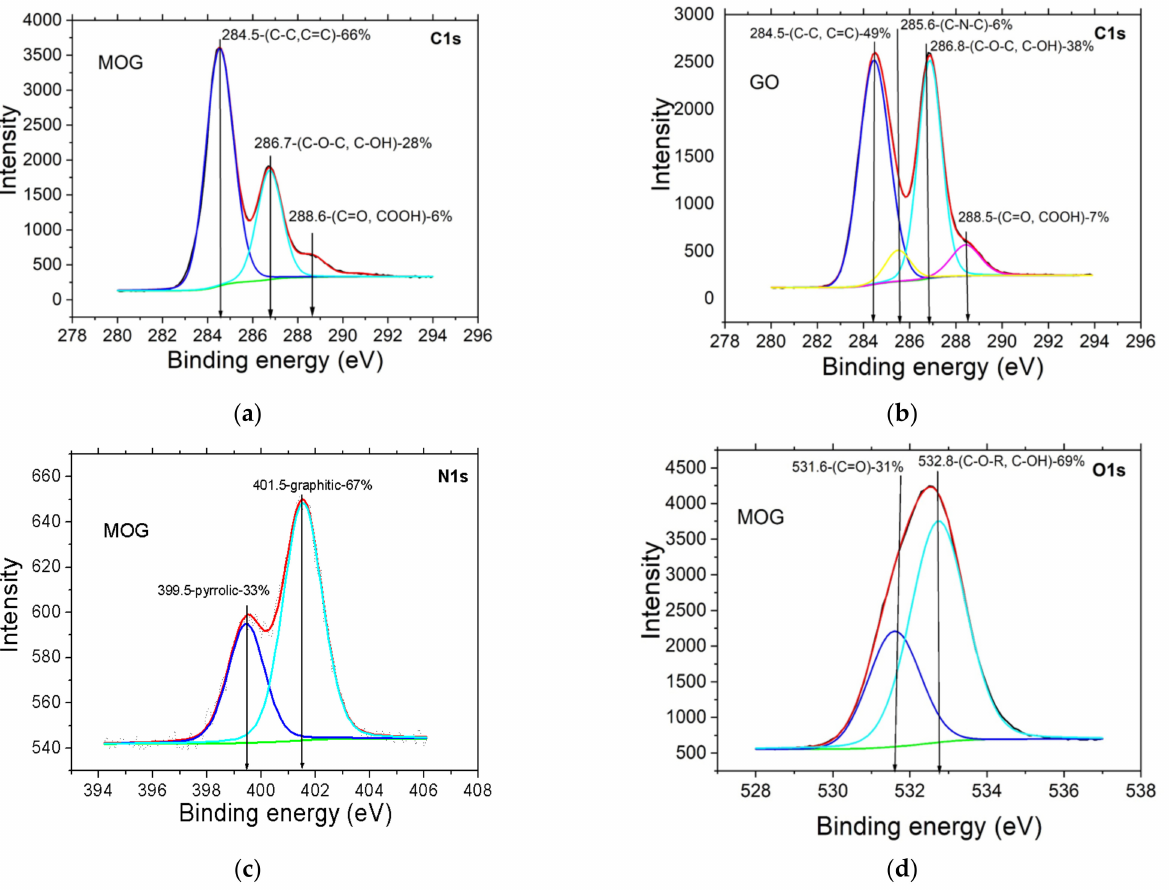
Figure 3. XPS spectra recorded in ranges of binding energies: ( a ) mildly oxidized graphene MOG— 280–294 eV, ( b ) GO—280–294 eV ( c ) MOG—394–406 eV, ( d ) MOG—528–537